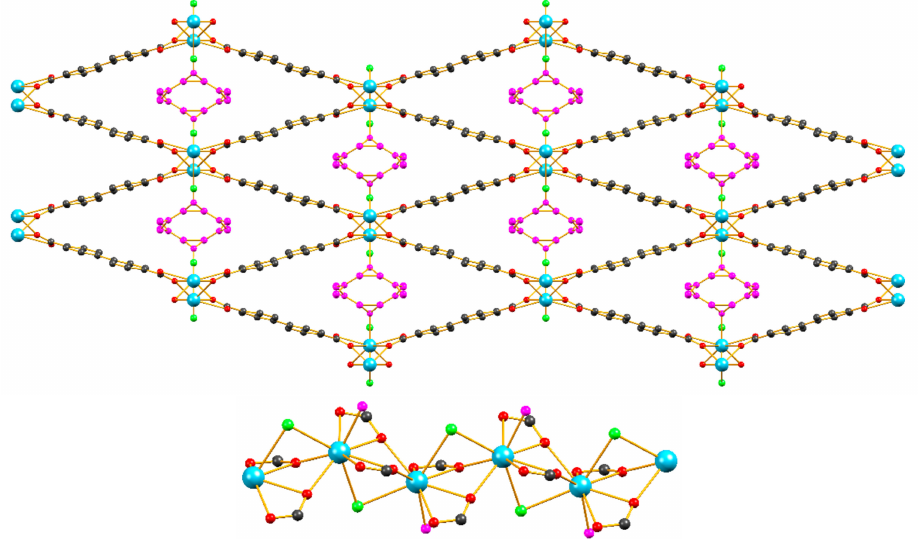
Figure 1. The crystal structure of the parent framework 1 [13] viewed along the a axis. The infinite rod metal SBU of 1 is shown below the main structure. Color code: Lanthanum: turqoise, Carbon: black, Oxygen: red, Chlorine: green. The atoms of the coordinated DMF molecules are shown in magenta.